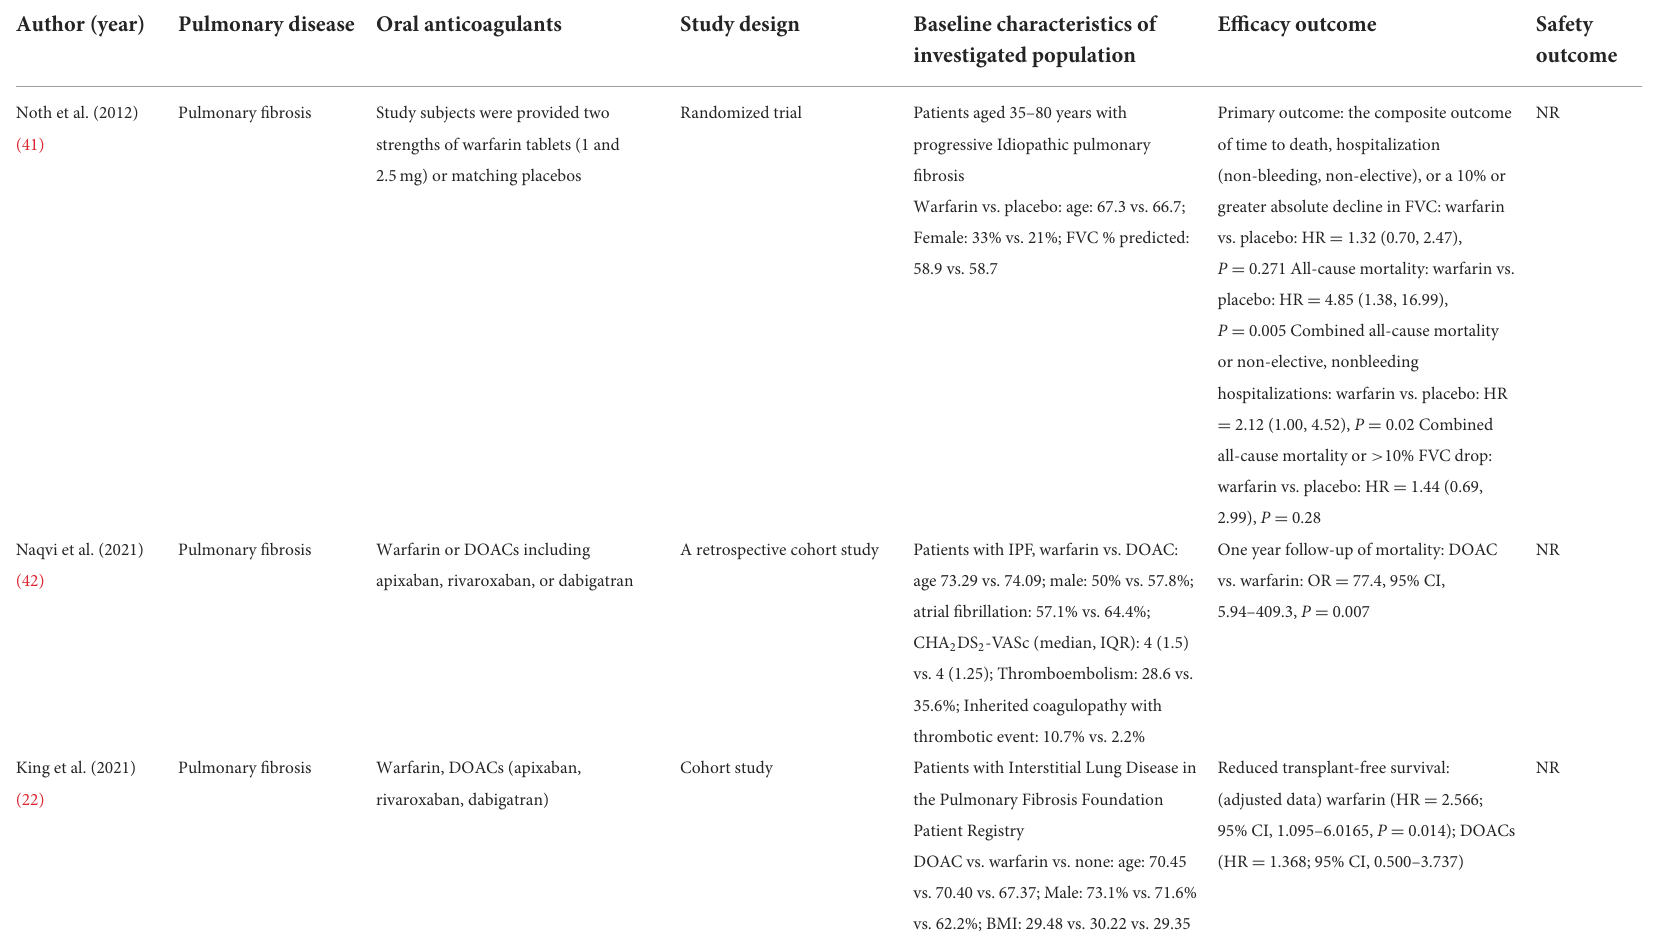
TABLE 3 Summary of included studies of OACs in patients with pulmonary